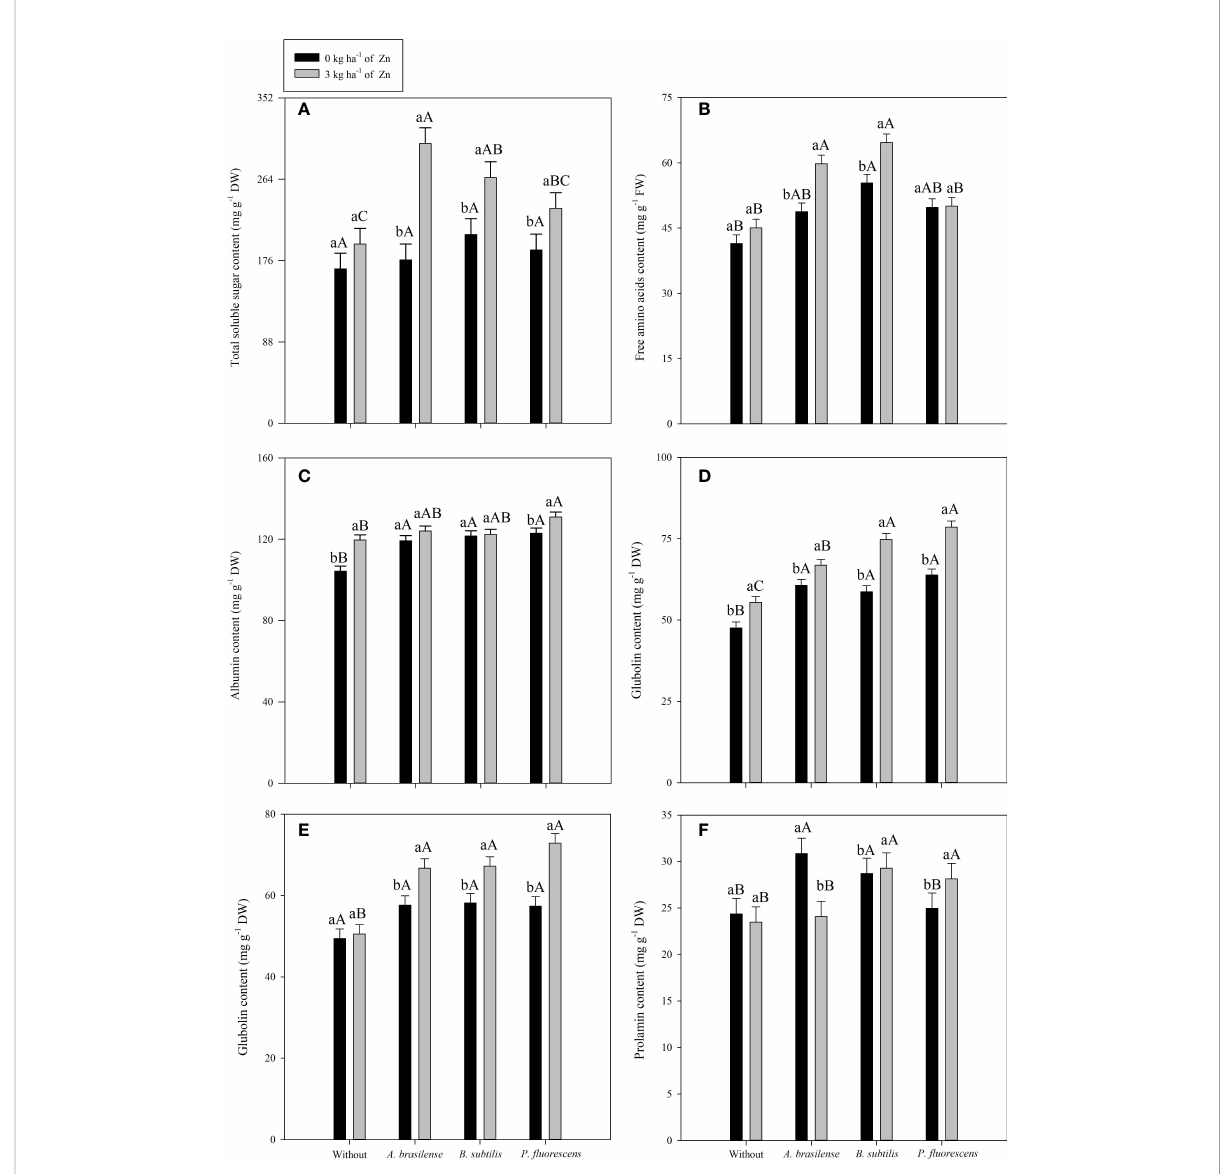
FIGURE 6 Concentrations of total soluble sugar in 2019 – 20 (A) , free amino acids in 2020 – 1 (B) , albumin in 2020 – 1 (C) , globulin in 2019 and 2020 ( D, E respectively) and prolamin in 2020 – 1 (F) as a function of plant growth-promoting bacteria with or without foliar zinc oxide (ZnO) application. Without = control (no inoculation). The uppercase letters compare interactions of inoculations within each dose of foliar nano-ZnO application and the lowercase letters are used to compare interactions of foliar zinc doses (presence and absence) within each inoculation treatment. The identical alphabetic letters do not different from each other by Tukey ’ s test ( p < 0.05) for foliar ZnO doses and inoculations in the 2019 – 20 and 2020 – 1 cropping seasons. Error bars indicate standard error of the mean ( n = 4